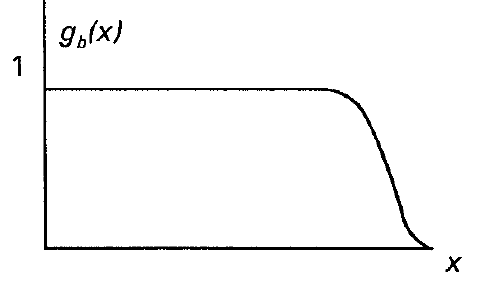
Figure 4: Utility of feature b, as a function gb(x) of SCA level